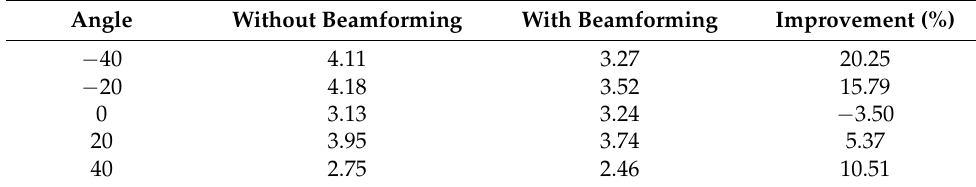
Table 6. The MAE of HR at 1.2 m.